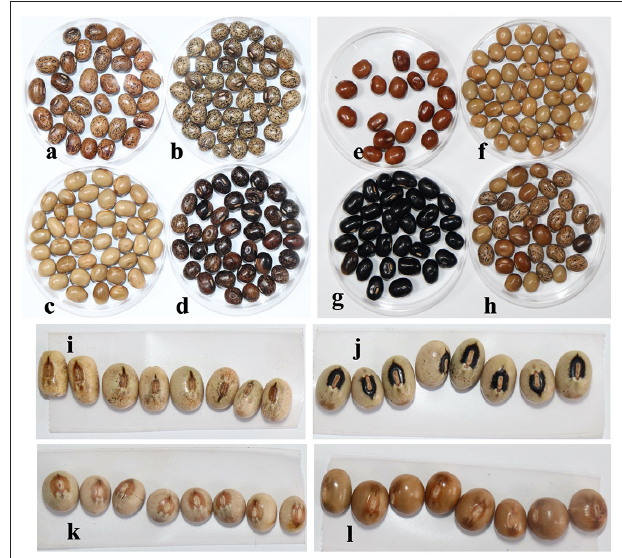
FIGURE 2 | Genetic varaition of seed triats in African yambean landraces for seed basel color (a) TSs-24 brown basal color, (b) TSs-27 Cream basal, (c) TSs-30 not variegated, (d) TSs-67 black basal; type of seed shape (e) TSs-39 Oval, (f) TSs-1 Rhomboid, (g) TSs-66 Oblong, (h) TSs-62 Round/globular; and seed eye color (i) TSs-81A clean eye color of white seed, (j) TSs-47 black eye color of white seed, (k) TSs-11 brown eye color of white seed, (l) TSs-1 non-white